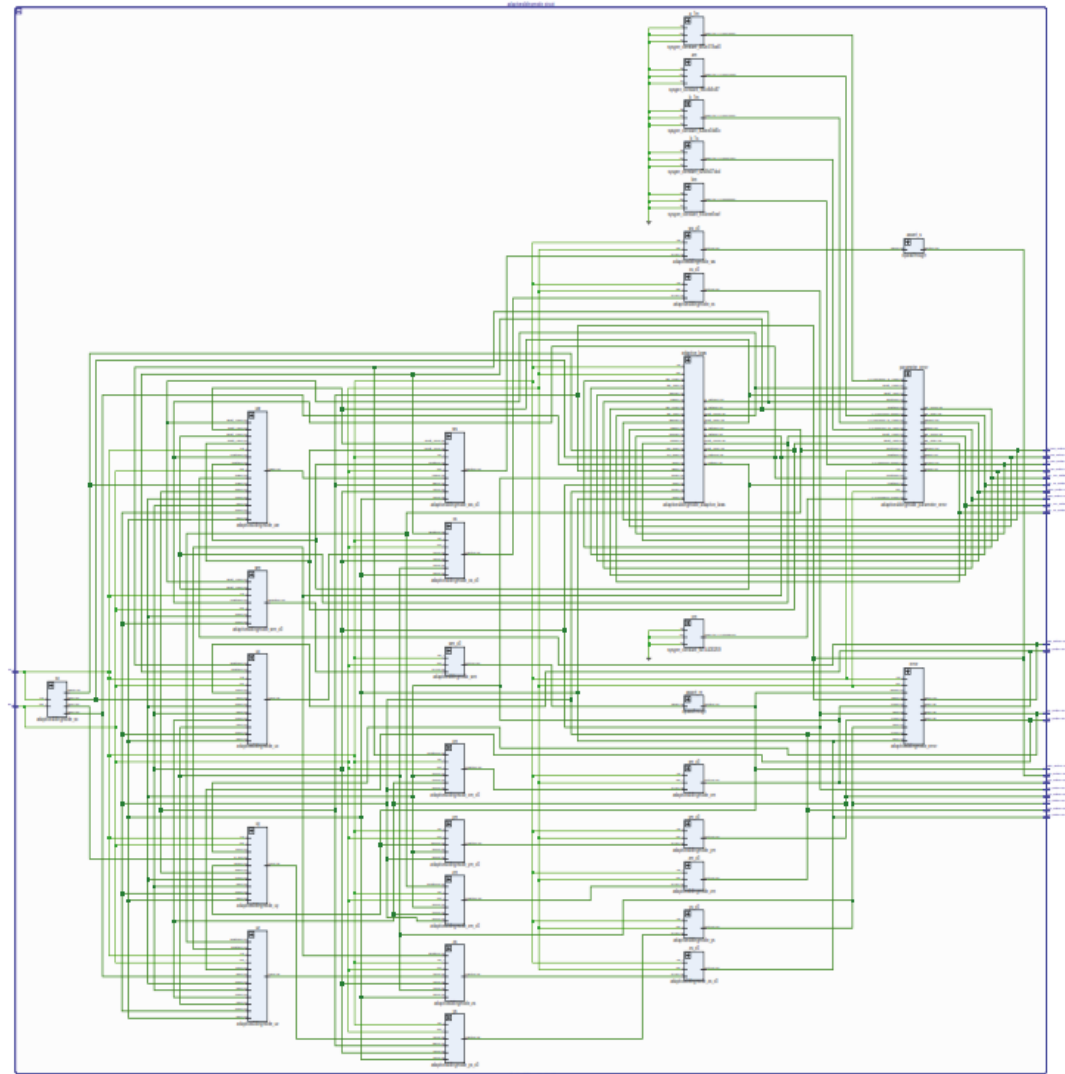
Figure 17: Xilinx schematics of the GAFOPID controllers implemented in Kintex 7 (device = 7k160t; package = fbg484 S).